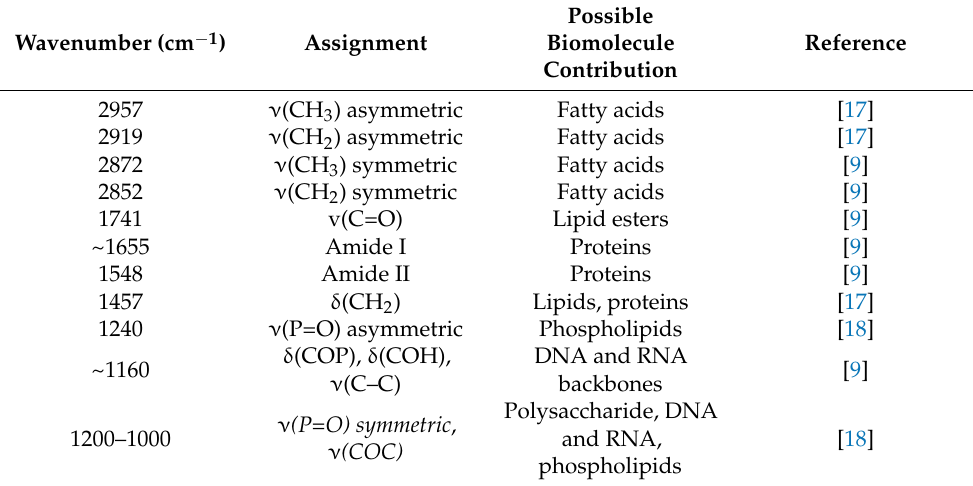
Figure 1. Mean FTIR spectra (after applying asymmetric least squares smoothing to remove baseline) of all bacterial cells from the concentration of 10 OD deposited on stainless steel ( a ) and the result after performing second derivative ( b ). The characteristic peaks are pointed out in the derivative spectra. Table 3. Assignment of absorbance bands for dry bacterial cells from the